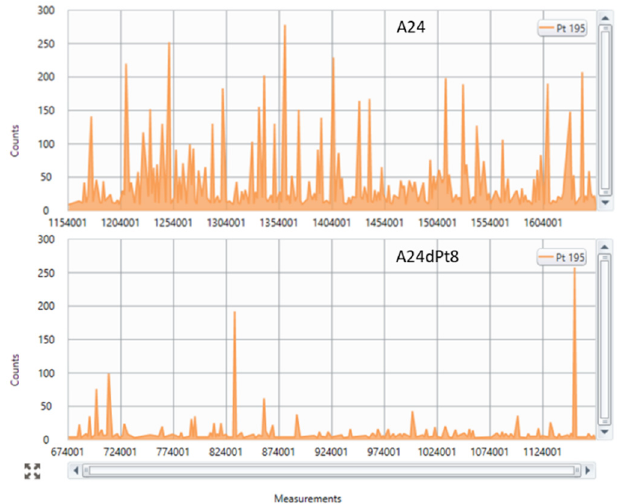
Figure 1. Single cell inductively coupled plasma mass spectrometry (SC-ICP-MS) representative sections of (Pt 195) counts versus time traces in A24 cells and A24dPt8 cells. This figure shows real-time signal processing by Syngistix. It becomes apparent that less Pt is measured in resistant cells (bottom panel) than compared to wild type (wt) cells (top panel), independent of the measured time point ( x -axis). Each “intensity peak” represents accumulated Pt 195 counts for a defined time interval (dwell time) of 50 µs. Each time interval correspond to one “single measurement” ( x -axis). Assumption: each peak (measurement) corresponds to one individual entity analyzed (cell, cells aggregate).